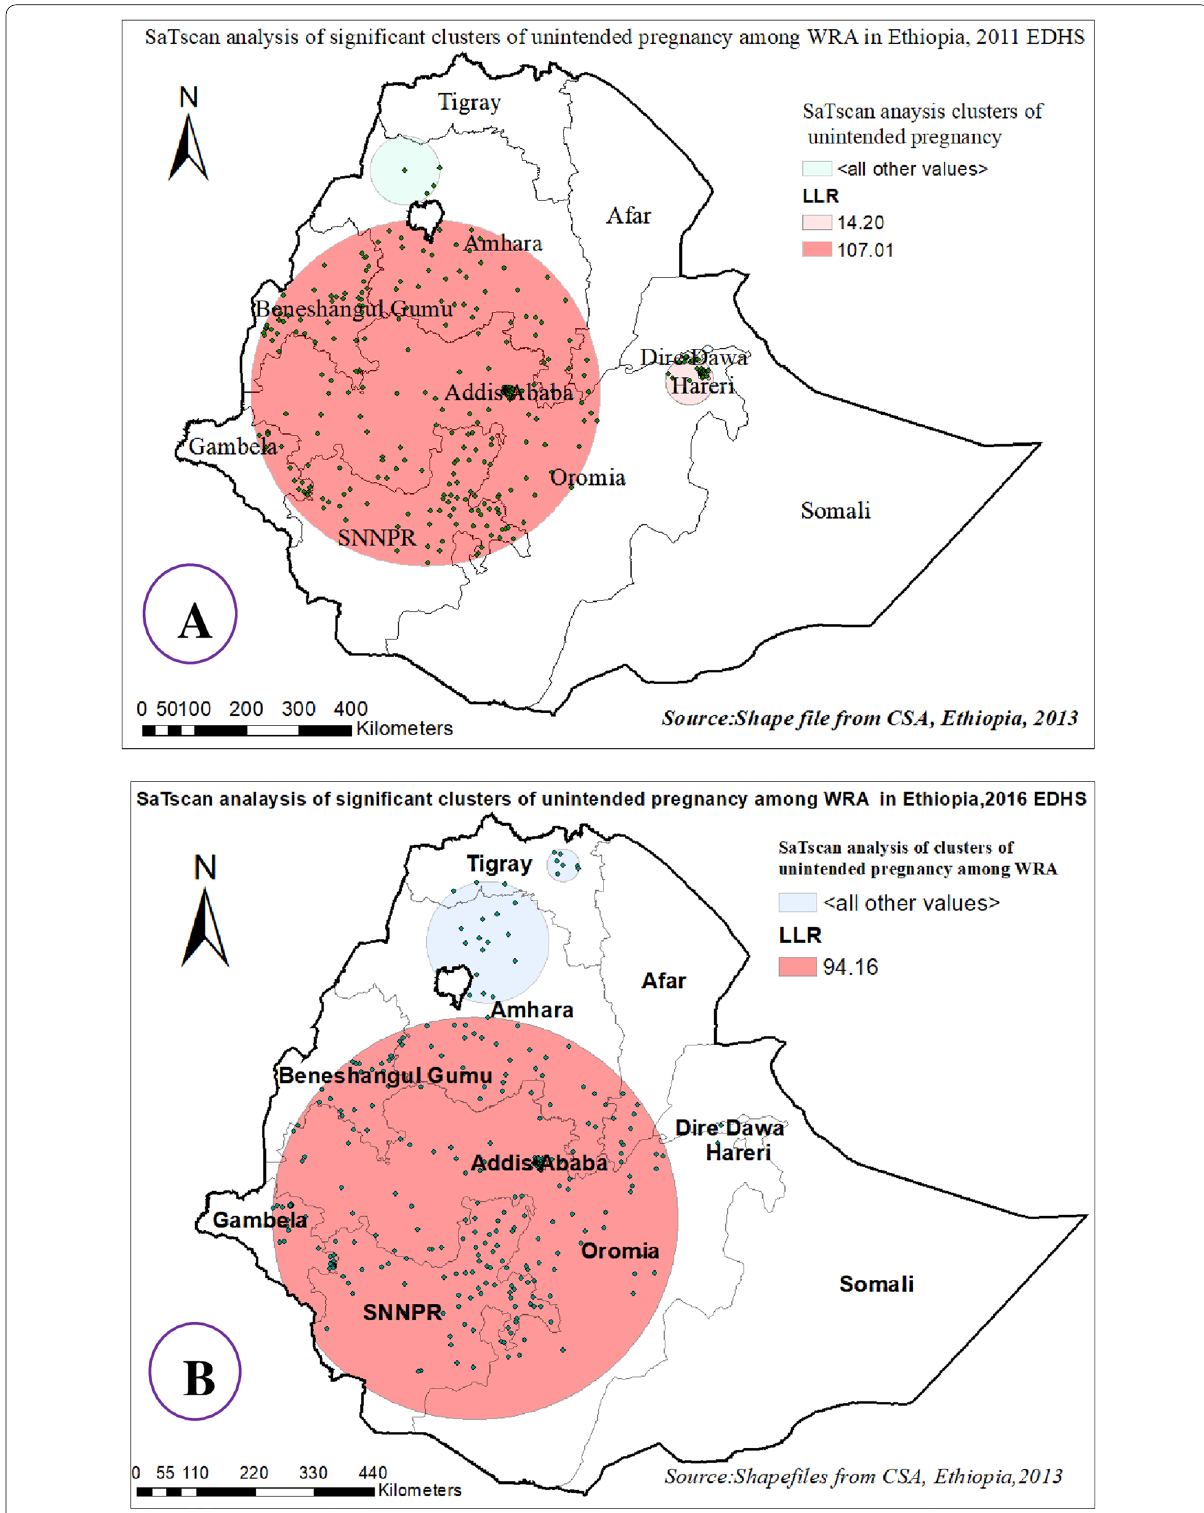
Fig. 6 SaTscan analysis of unintended pregnancy among reproductive-age women Ethiopia, 2011 EDHS ( A ) and 2016 EDHS ( B